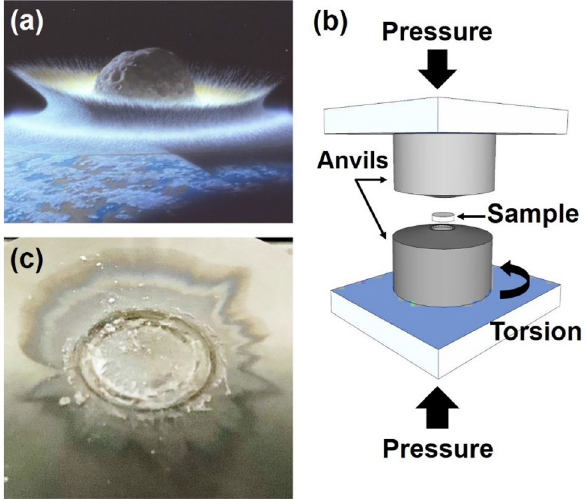
Figure 1. ( a ) Illustration of impacts by meteoroids, asteroids, comets and transitional objects on the Earth 10 ; ( b ) schematic of high-pressure torsion method and its anvils 13 ; and ( c ) surface of high-pressure torsion anvil after a small explosion caused by processing glycine under 6